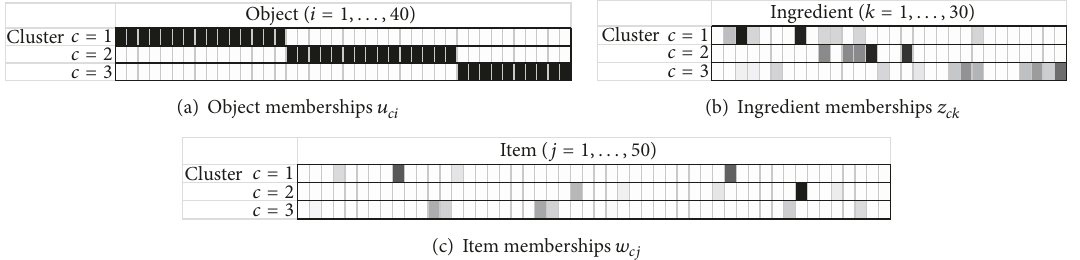
Figure 3: Derived memberships by proposed 3Fuzzy CoDoK.